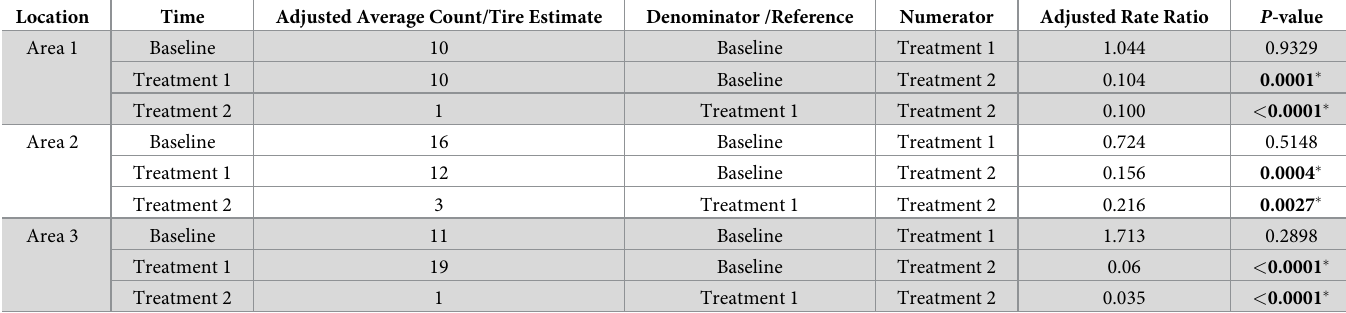
Table 4. Simple effect comparisons of median larvae Aedes aegypti densities per location per treatment using least squares means. Location